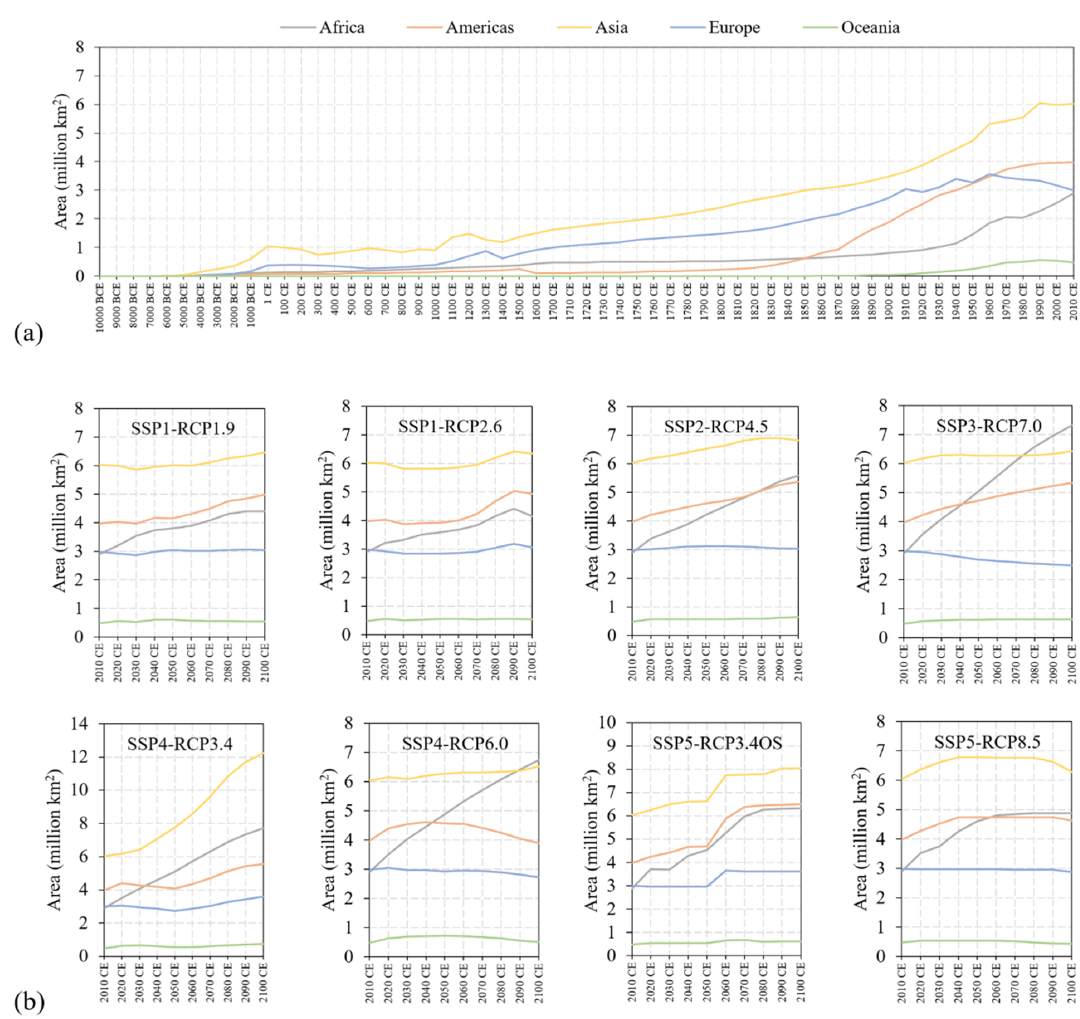
Figure 10. Cropland area of different continents for (a) 10000BCE–2010CE and (b) 2010CE–2100CE under eight future scenarios. The division of continents is based on countries and is identical to FAO statistics.